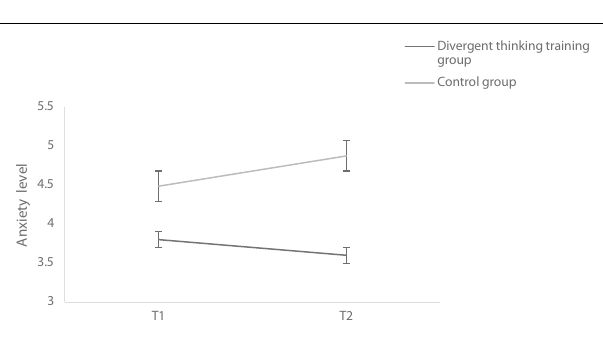
FIGURE 3 | Anxiety of two groups before intervention (T1) and 9 days after intervention (T2). The error line represents the standard error.